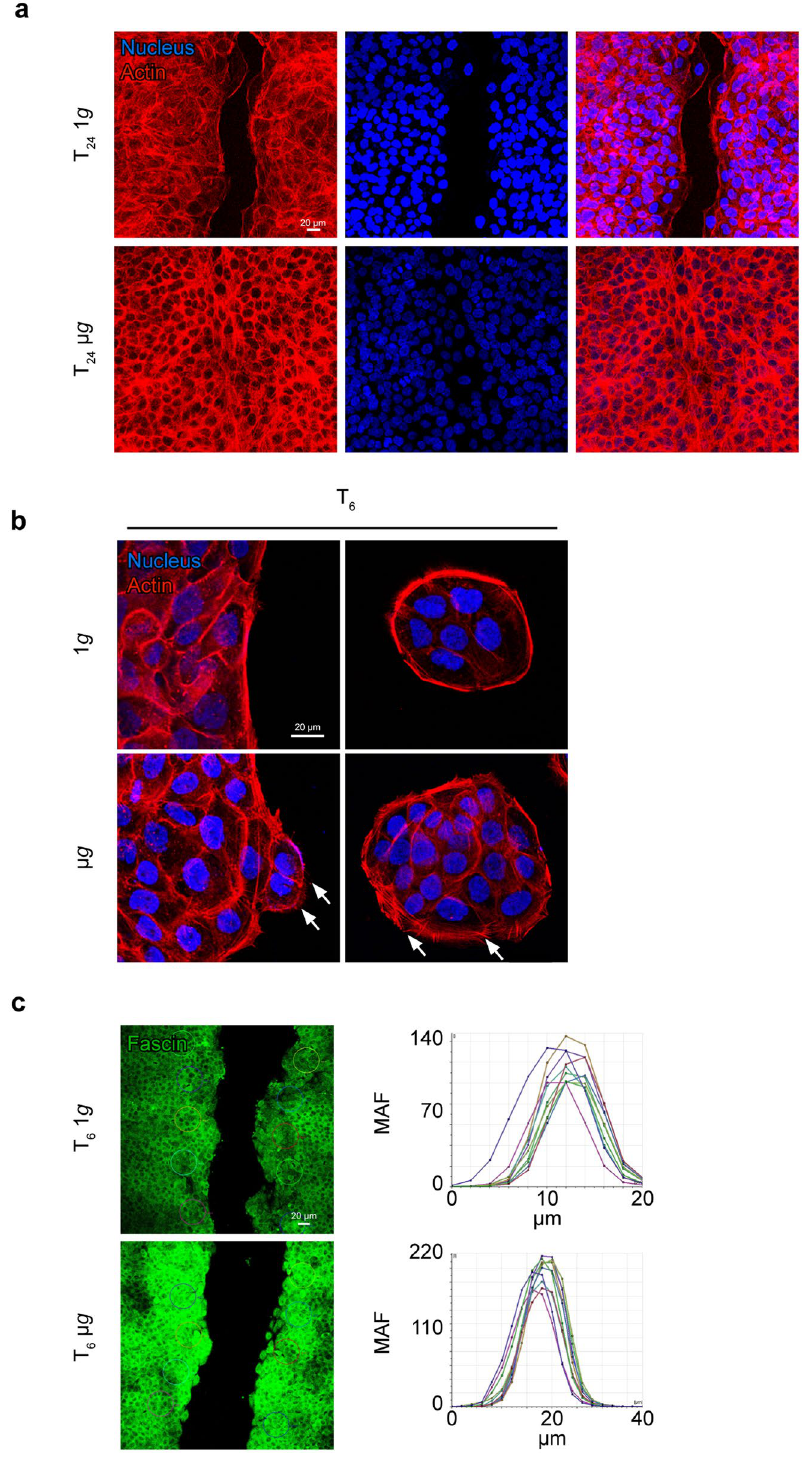
Figure 2. Simulated microgravity exposure affects keratinocyte growth mode and their morphology during migration. ( a ) Fluorescence analysis using TRITC-phalloidin, to visualize the F-actin cytoskeleton, on the scratch assay performed as in Fig. 1, confirms that in μ g cultures the scratch area is sealed, while only few migrating cells are visible in the corresponding control cultures. ( b ) Fluorescence performed as above in cells grown until semi- confluence and exposed to μ g for 6 hours shows that, in control cultures, cells maintain an actin cytoskeleton organization in peripheral cortical bundles (top panels); in μ g -treated cultures, lamellipodia and ruffles are frequently observed in peripheral cells (bottom panels, arrows). ( c ) Scratch assay was performed as reported above and cells were left to migrate for 6 hours. Quantitative immunofluorescence analysis, expressed as Max Amplitude Fluorescence (MAF), shows that fascin is increased in μ g exposed cells compared to